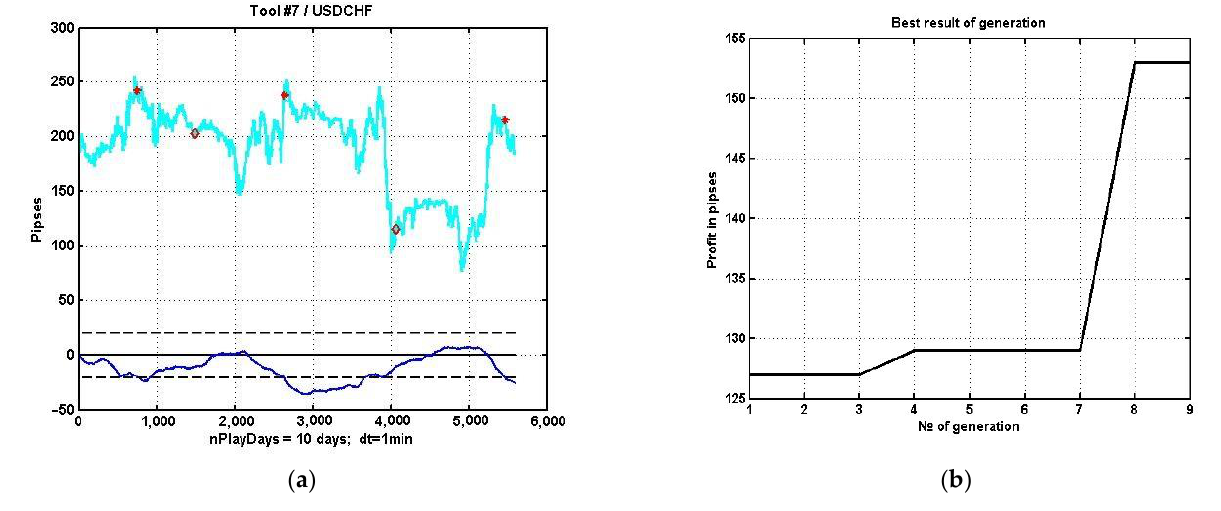
Figure 12. ( a ) An example of a suboptimal management strategy using a non-adaptive MR oscillator. ( b ) The dependence of the gain increase on the generation number for this strategy.